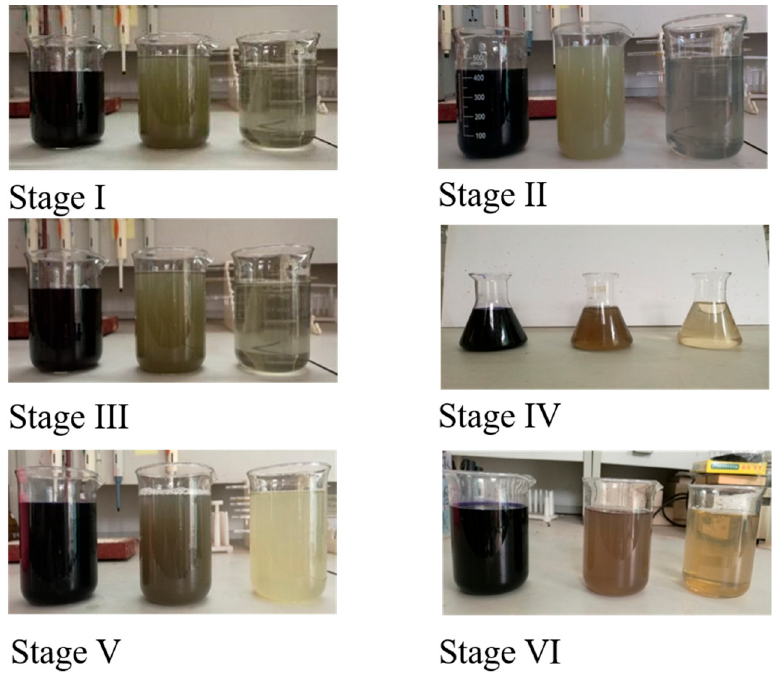
Figure 2. Color changes during the study (left: Influent; middle: Treated by anaerobic microorganisms; right: Filtrate).